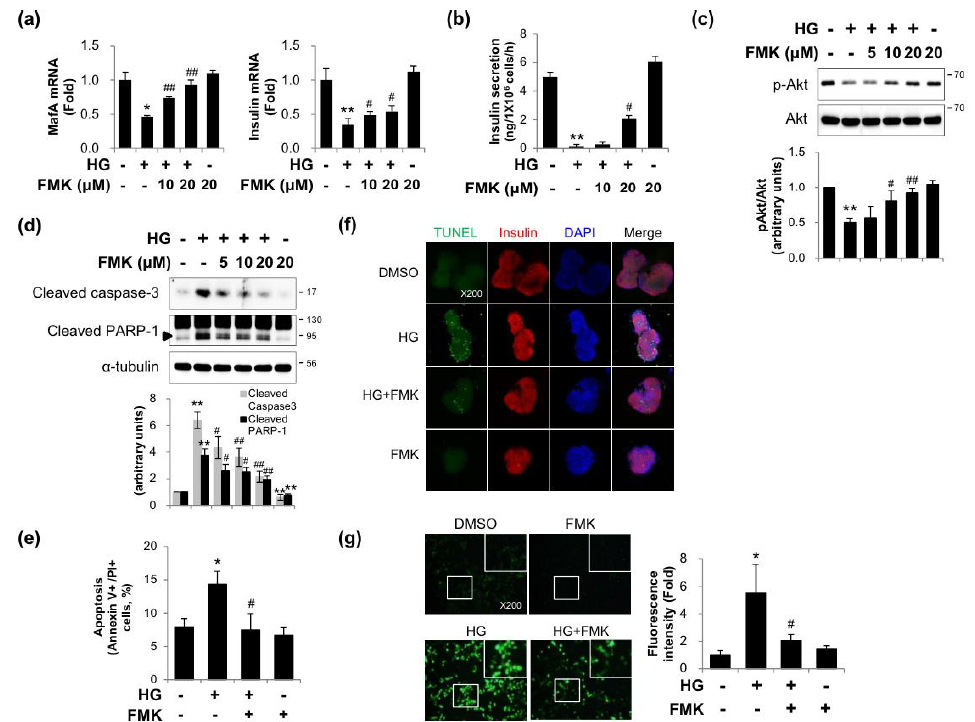
Figure 1. FMK pretreatment prevented high glucose-induced β -cell dysfunction, apoptosis, and oxidative stress. ( a ) INS-1 cells were pretreated with FMK (10 or 20 μM) for 1 h, and then incubated with high glucose (HG, 25 mM) for 24 h. mRNA levels of MafA and insulin were measured by qRT-PCR. Relative expression levels were normalized versus GAPDH. Results are expressed as means ± SD and are representative of three independent experiments. * p < 0.05 and ** p < 0.01 vs. non-treated controls, # p < 0.05 and ## p < 0.01 vs. HG-treated cells. ( b ) INS-1 cells were pretreated with FMK (10 or 20 µ M) for 1 h, and then incubated with HG for 48 h, and then replaced with fresh medium. After 5 h recovery, the cells were subsequently simulated with KRB supplemented with HG for 1 h, and then the medium was collected for detection of glucose-stimulated insulin secretion (GSIS). Insulin secretion was determined by ELISA kit. Results are expressed as means ± SD and are representative of three independent experiments. ** p < 0.01 vs. non-treated controls, # p < 0.05 vs. HG-treated cells. ( c , d ) INS-1 cells were pretreated with FMK (5, 10 or 20 µ M) for 1 h, and then incubated with HG for 48 h. Protein levels were measured by immunoblotting. The graph shows the densitometric quantification of western blot bands. Results are expressed as means ± SDs and are representative of three independent experiments. ** p < 0.01 vs. non-treated controls, # p < 0.05 and ## p < 0.01 vs. HG-treated cells. ( e ) INS-1 cells were pretreated with FMK (20 µ M) for 1 h and then incubated with HG for 48 h. The status of apoptotic cell death was determined by counting cells stained with annexin V-FITC / PI using a flow cytometer. ( f ) Primary rat islets were pretreated with FMK (20 µ M) for 1 h and then incubated with HG for 48 h. Cells were subjected to TUNEL staining. Representative photomicrographs showing TUNEL (apoptotic, green), insulin (pancreatic β -cells, red), and DAPI (nuclei, blue) signals and merged images (original magnification, × 200). ( g ) Representative images of ROS accumulation as determined using the fluorescent probe H2DCFDA. INS-1 cells were pretreated with FMK (20 µ M) for 1 h and then